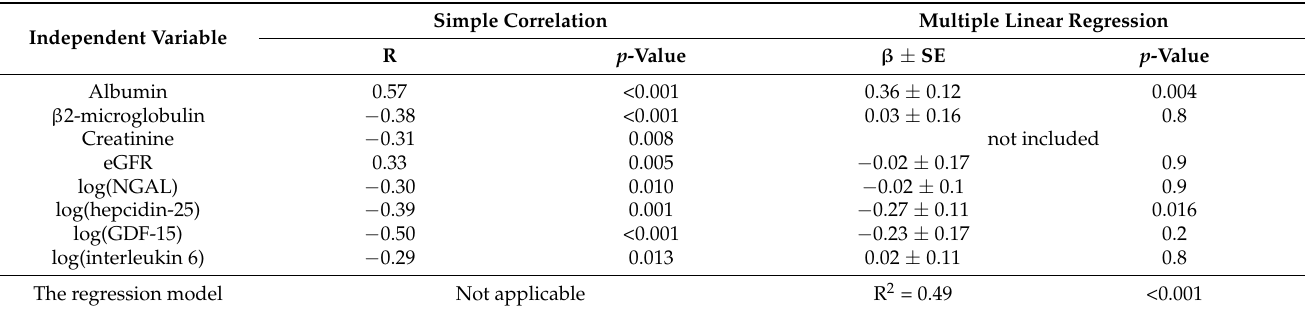
Figure 3. Soluble transferrin receptor (sTfR, ( A )), hepcidin-25 ( B ), and ferritin ( C ) in serum of studied patients with MM according to treatment status; serum sTfR ( D ) and hepcidin-25 ( E ) in patients with MM according to the response to treatment. The data are shown as median (central line), interquartile range (box), non-outlier range (whiskers), and outliers (points); p -values in Mann–Whitney ( A – C ) or Kruskal–Wallis ( D , E ) test are shown, asterisk depicts significant differences in post-hoc comparisons. Table 3. Significant predictors of blood hemoglobin concentrations among studied patients in MM in simple analysis and the results of multiple regression. Multiple regression model was adjusted for sex, treatment status, and the response to